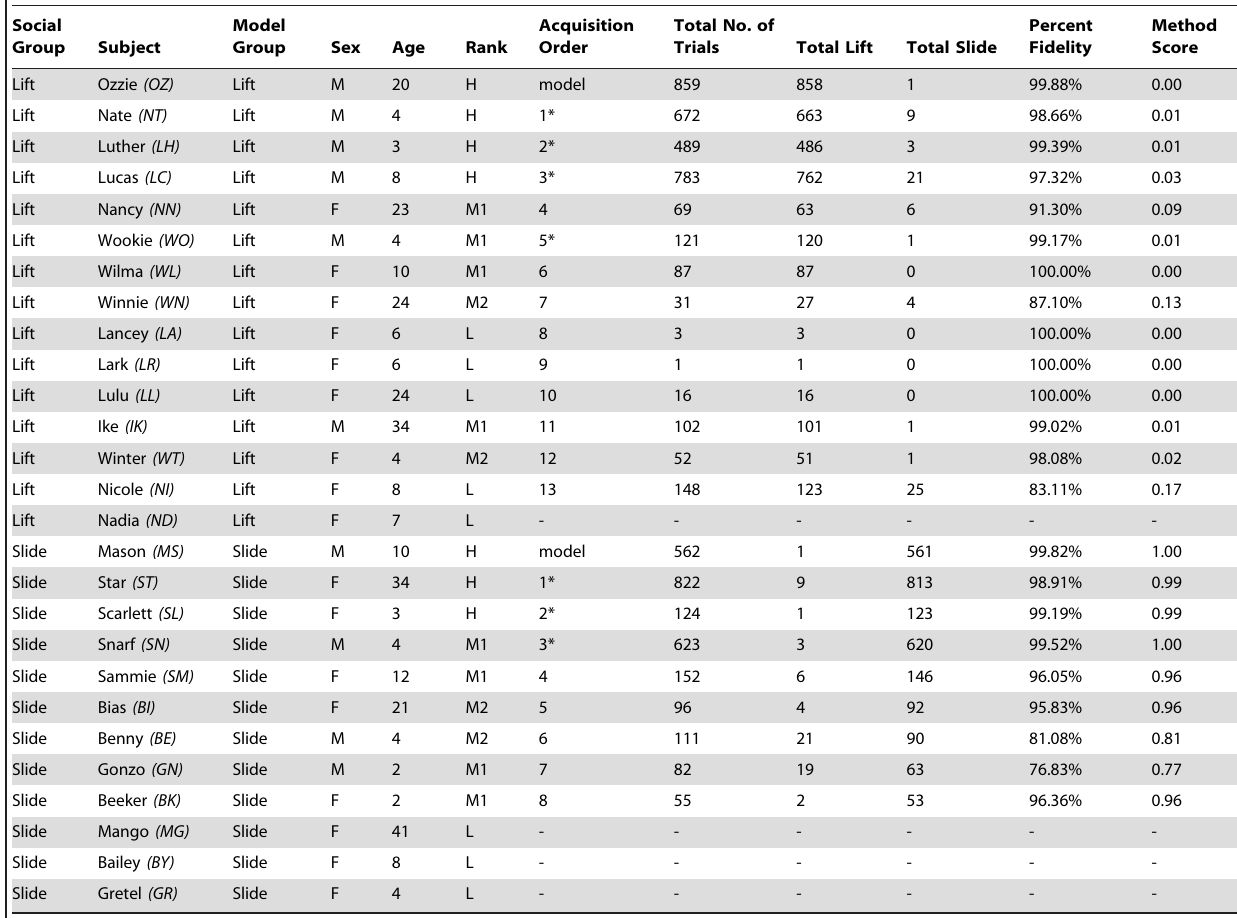
Table 1. Method acquisition